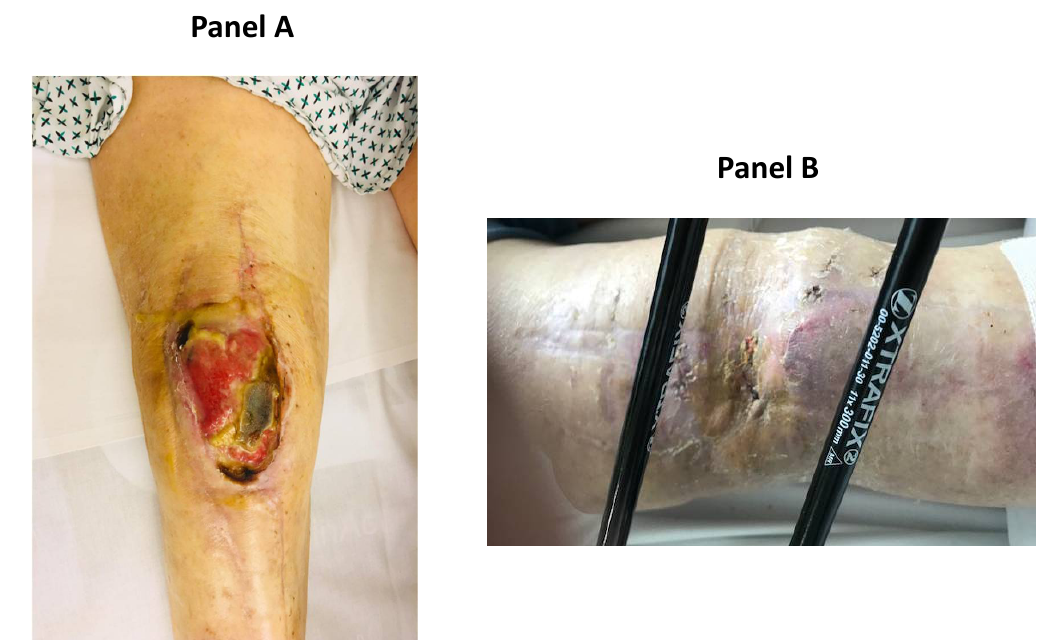
Figure 1. A: Photograph demonstrating septic surgical wound of the right knee after removal of the prosthesis (by S. Hominis). B: Photograph demonstrating the wound healing of the right knee after three months from the positioning of the external fixator.